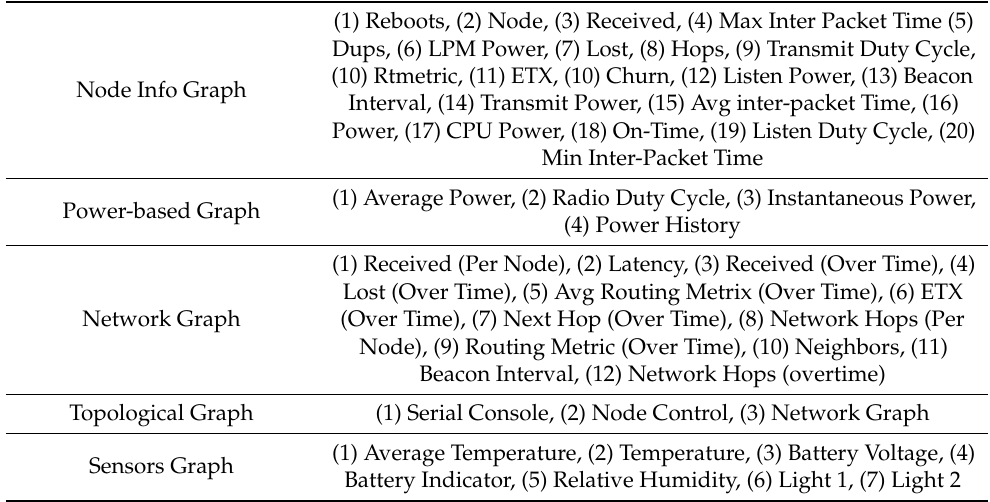
Table 3. Characteristics of the Cooja simulator.